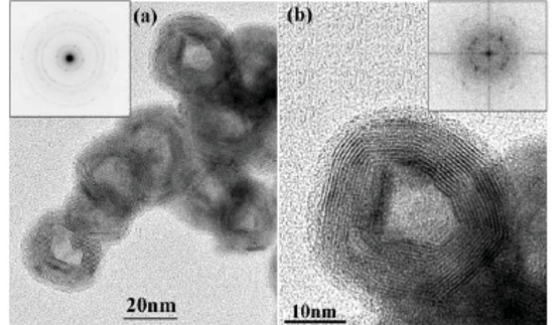
Figure 10. TEM micrographs of the annealed IF-NbS cles: (a) a group of such nanoparticles and their SAED in the inset; (b) higher magnification of one of the nanoparticles showing the closed nature of the layers and FFT of the nanoparticle in the inset (adapted from Ref. 40).